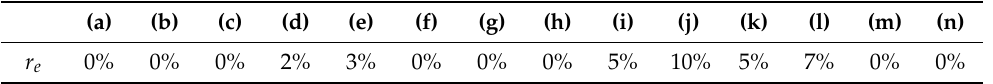
Table 4. The polarity judgment error rates r e of 14